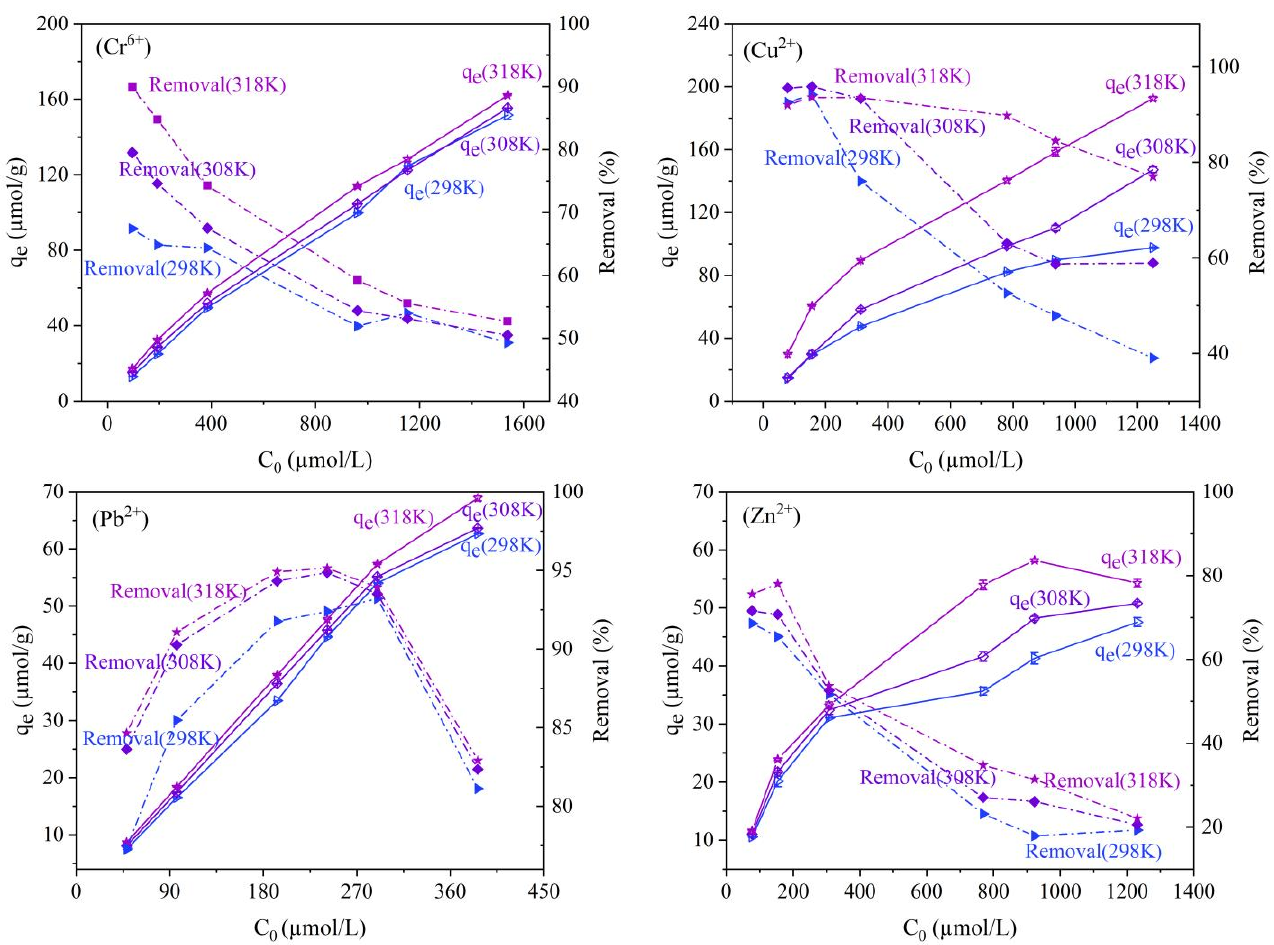
Figure 5. Effects of initial concentration and temperature on adsorption of Cr 6+ , Cu 2+ , Pb 2+ , and Zn 2+ onto magnetic nano-chitosan in aqueous solution.